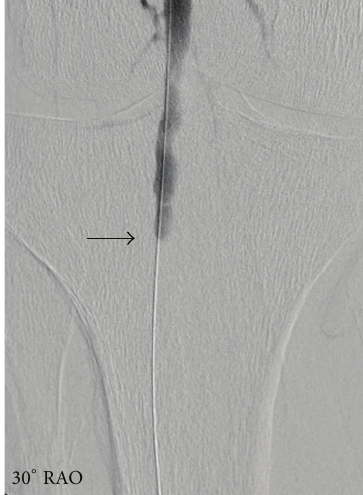
Figure 4: Percutaneous transluminal angiography demonstrating the occlusion of the right popliteal artery (black arrow).